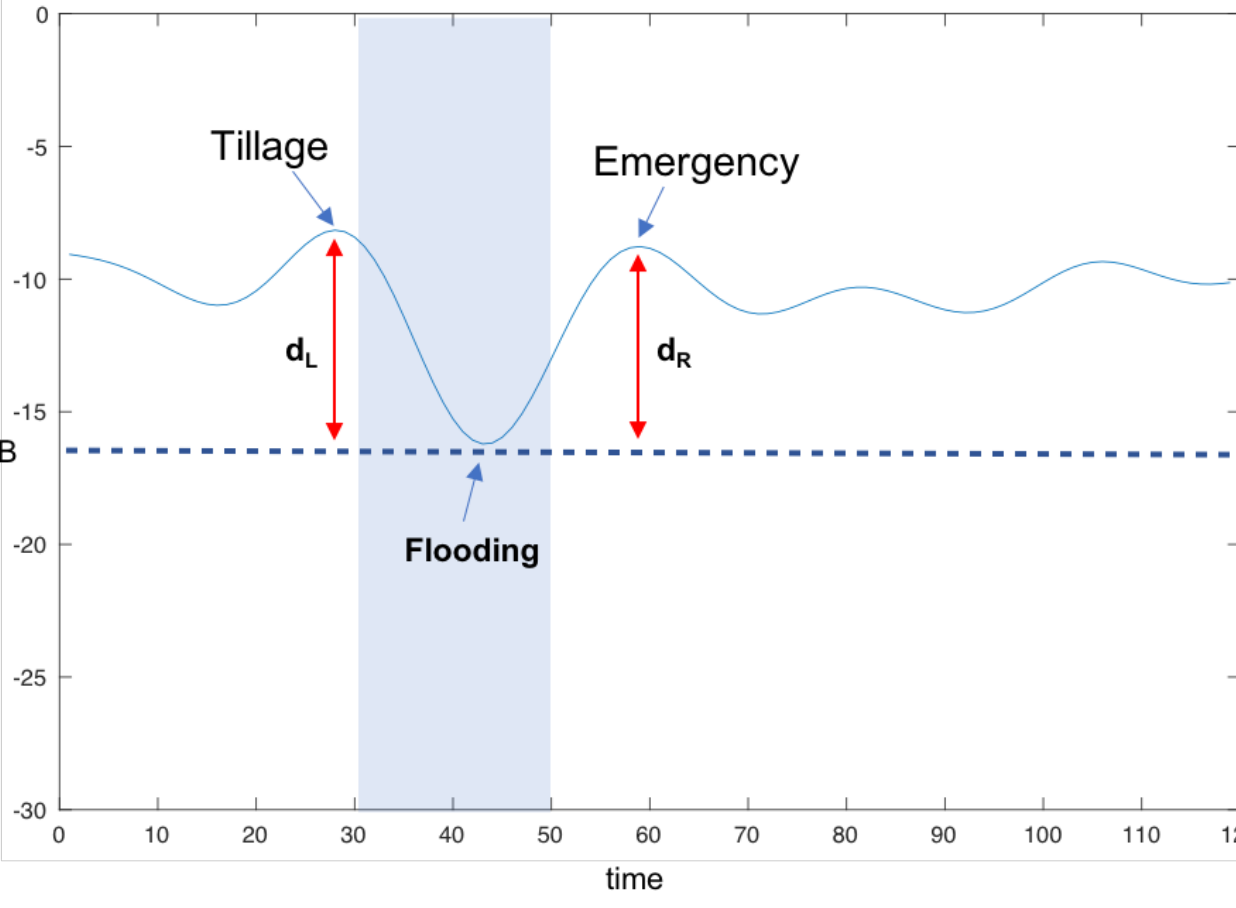
Figure 7. Smoothed, typical rice field SAR time-series. The horizontal axis is denominated by satellite pass count, and the blue band between 30 and 50 roughly marks the typical rice paddy field flooding period in April/May. The parameters d L and d R represent the height above the minimum of the peaks on the two sides of the spring reflectivity plunge associated with the customary, longest flooding period. In the proposed classification algorithm, d L and d R are compared with a threshold in the